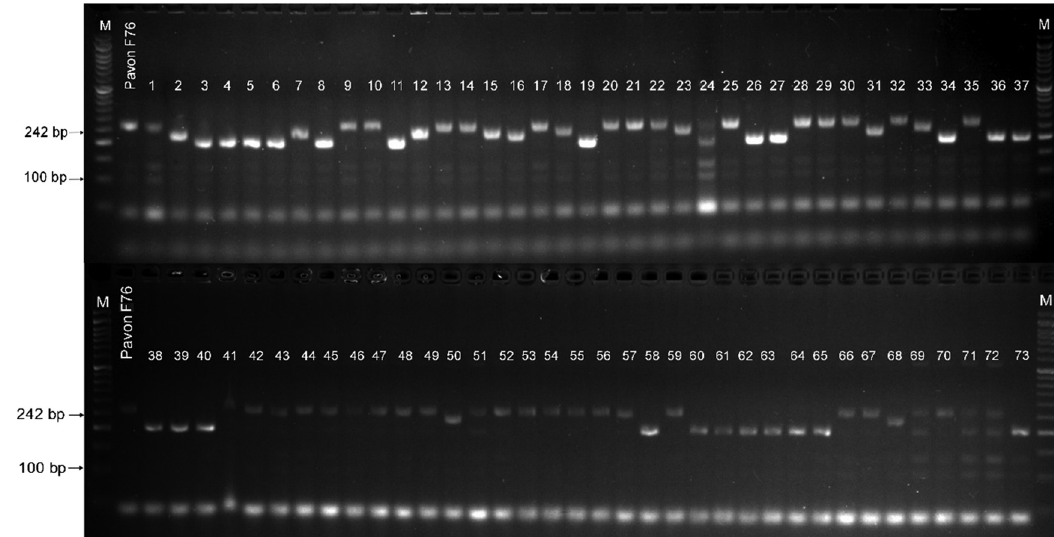
Figure 1: Electropherogram showing the presence of molecular marker Xwmc44 in tested genotypes. M, FastGene 50 bp DNA Ladder ( NIPPON Genetics EUROPE GmbH ) ; 1 – 73 – wheat